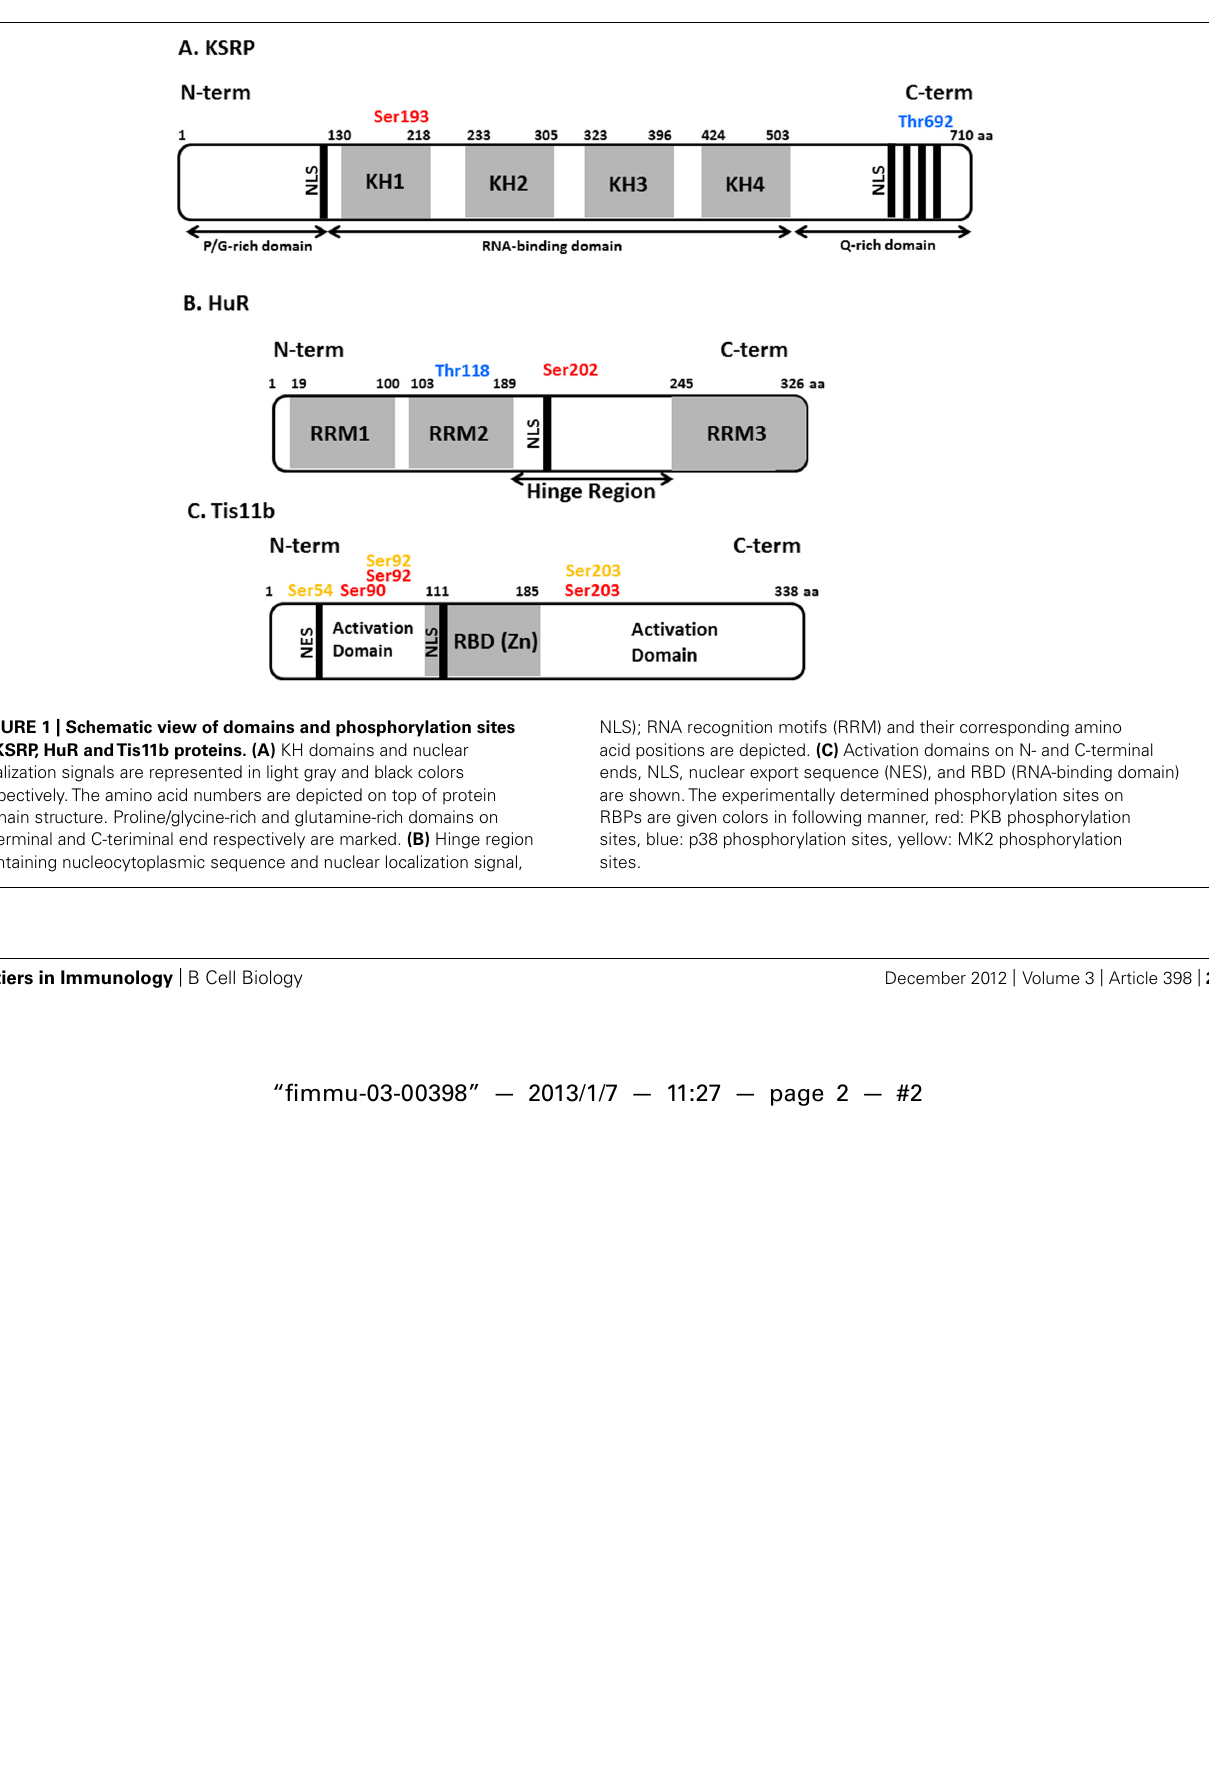
FIGURE 1 | Schematic view of domains and phosphorylation sites in KSRP, HuR andTis11b proteins. (A) KH domains and nuclear localization signals are represented in light gray and black colors respectively.The amino acid numbers are depicted on top of protein domain structure. Proline/glycine-rich and glutamine-rich domains on N-terminal and C-teriminal end respectively are marked. (B) Hinge region (containing nucleocytoplasmic sequence and nuclear localization signal,